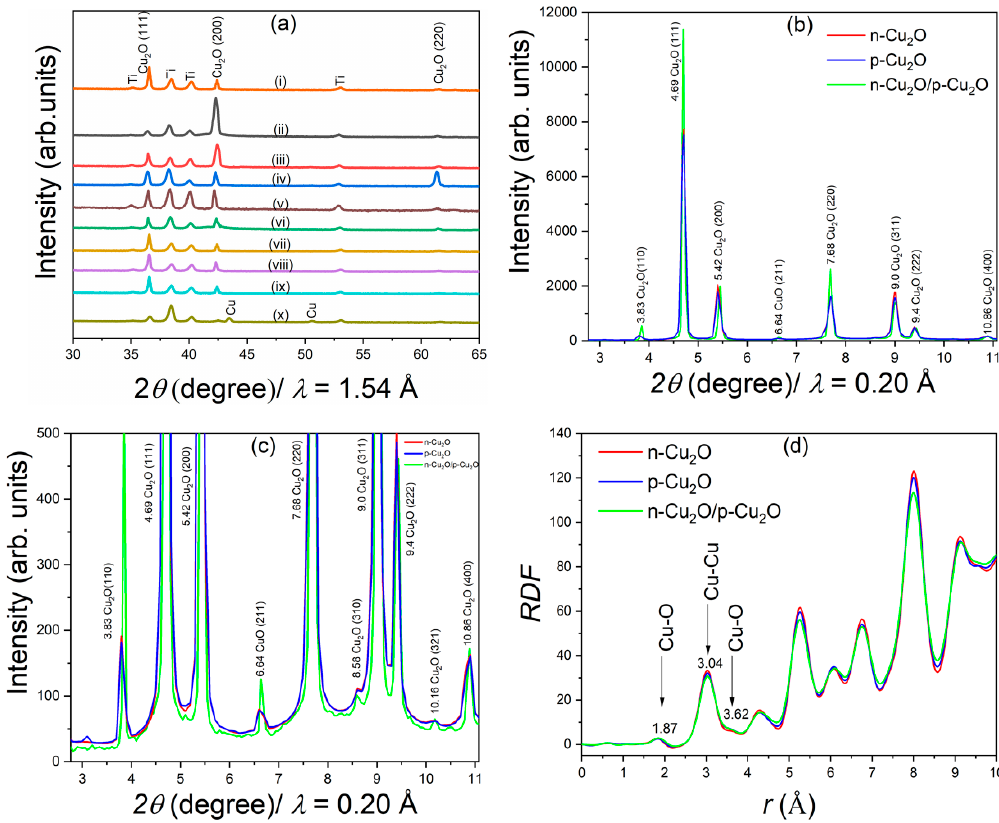
Figure 1. ( a ) X-ray di ff raction (XRD) pattern of Cu 2 O thin films electrodeposited at acetate bath pH of 5.8 (a), lactate bath pH of 9.5 (ii), 10 (iii), 10.5 (iv), 11 (v), 11.5 (vi), 12 (vii), 12.5 (viii), 13 (ix), and 13.5 (x). ( b ) high-energy X-ray di ff raction (HEXRD) patterns of the electrodeposited Cu 2 O thin films n -type Cu 2 O prepared at pH 5.8 (red line), p -type Cu 2 O prepared at pH 12.5 (blue line), and n -Cu 2 O (pH 5.8) / p -Cu 2 O (pH 12.5) homojunction (green line). ( c ) Enlarged view of HEXRD patterns of the electrodeposited Cu 2 O thin films n -type Cu 2 O prepared at pH5.8 (red line), p -type Cu 2 O prepared at pH 12.5 (blue line), and n -Cu 2 O (pH 5.8) / p -Cu 2 O (pH 12.5) homojunction (green line). ( d ) Radial distribution functions of n -type Cu 2 O prepared at pH 5.8 (red line), p -type Cu 2 O prepared at pH 12.5 (blue line), and and n -Cu 2 O (pH 5.8) / p -Cu 2 O (pH 12.5) (green line) homojunction.